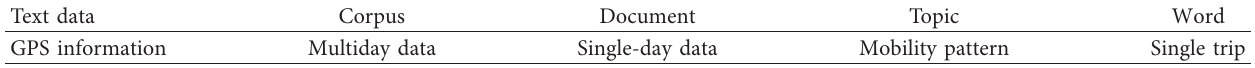
Table 2: The analogy between the GPS information and the text data.